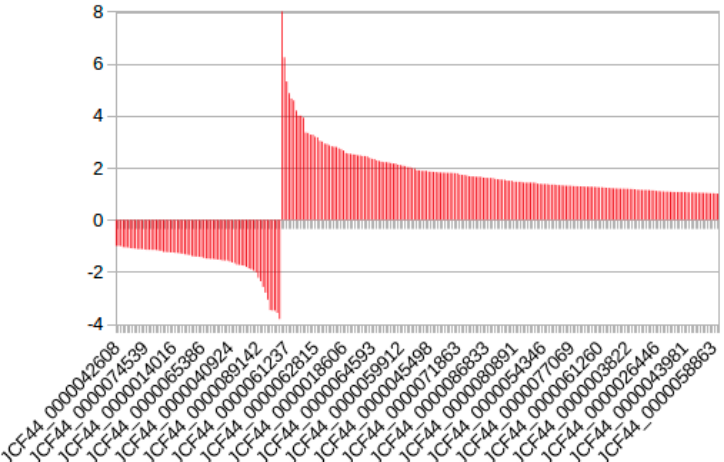
Figure 8. log2fold change comparison of copaíba lncRNA conserved in Fabaceae species: A total of 1141 lncRNA aligned to multiple Fabaceae genomes and transcriptomes. Comparing the expression of the ARF against CER samples, we found 256 transcripts that presented log2fc above 1. The graph displays the regulated transcripts of ARF samples compared to CER, each bar corresponds to a single transcript. It is possible to notice that 24 transcripts are regulated above